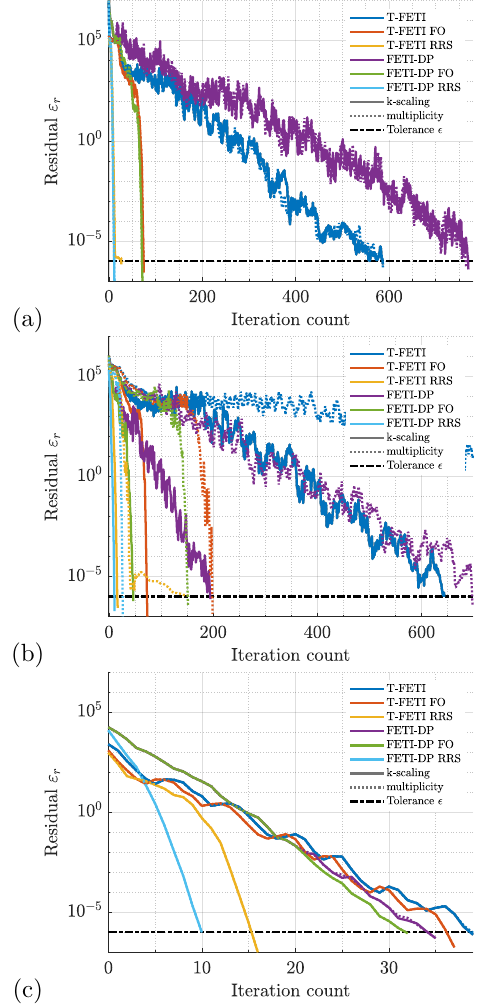
Figure 2. Convergence history of 12 variants of the solution strategies for the three academic problems shown in Fig. 1: a) a laminated beam, b) a 3 × 3 grid of laminated subdomains, and, c) a 4 × 4 grid of sub- domains with stiff square inclusions. FO denotes full orthogonalization enhancement, RRS stands for the simultaneous variant with rank-revealing decomposi- tion. In all graphs, results with the k -scaling enhance- ment are plotted in solid lines while the dotted lines represent the multiplicity scaling. The dash-dotted line mark the desired residual threshold ϵ from Algo- rithm